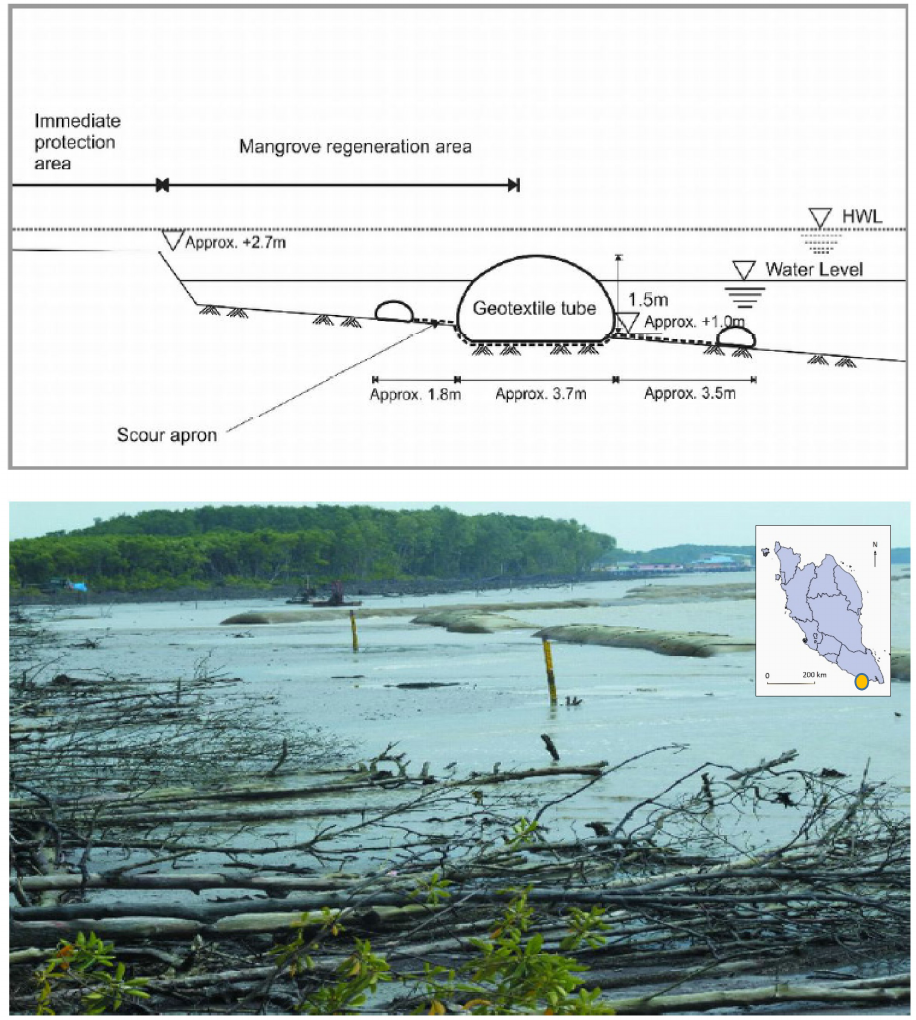
Figure 15. Geotextile tube as mangrove forest erosion control in Tg Piai [101]. ‘Reprinted from Geotextile Tubes for Protection of Mangrove Coast in Malaysia, 2007; open access publication by UMP